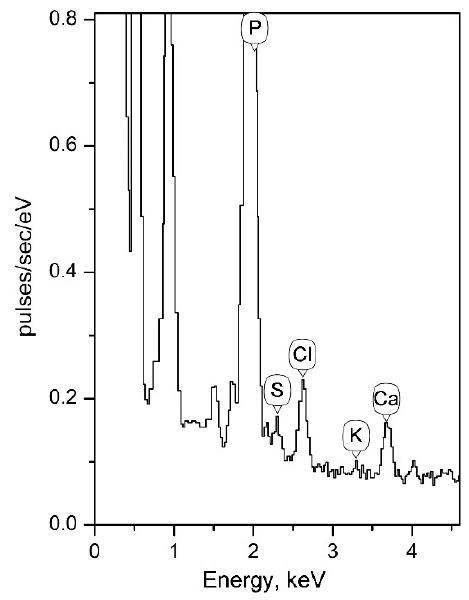
Figure 5. X-ray spectrum of a total cell preparation of the strain F2E.